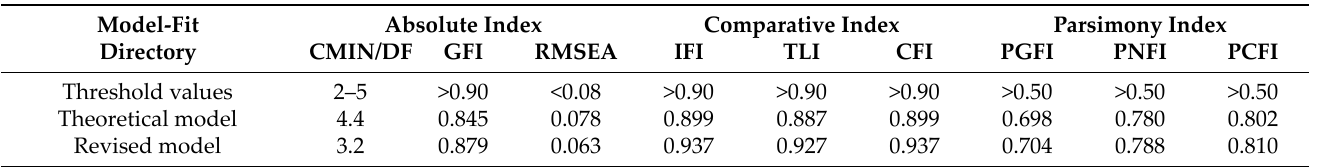
Table 5. Goodness‑of‑fit